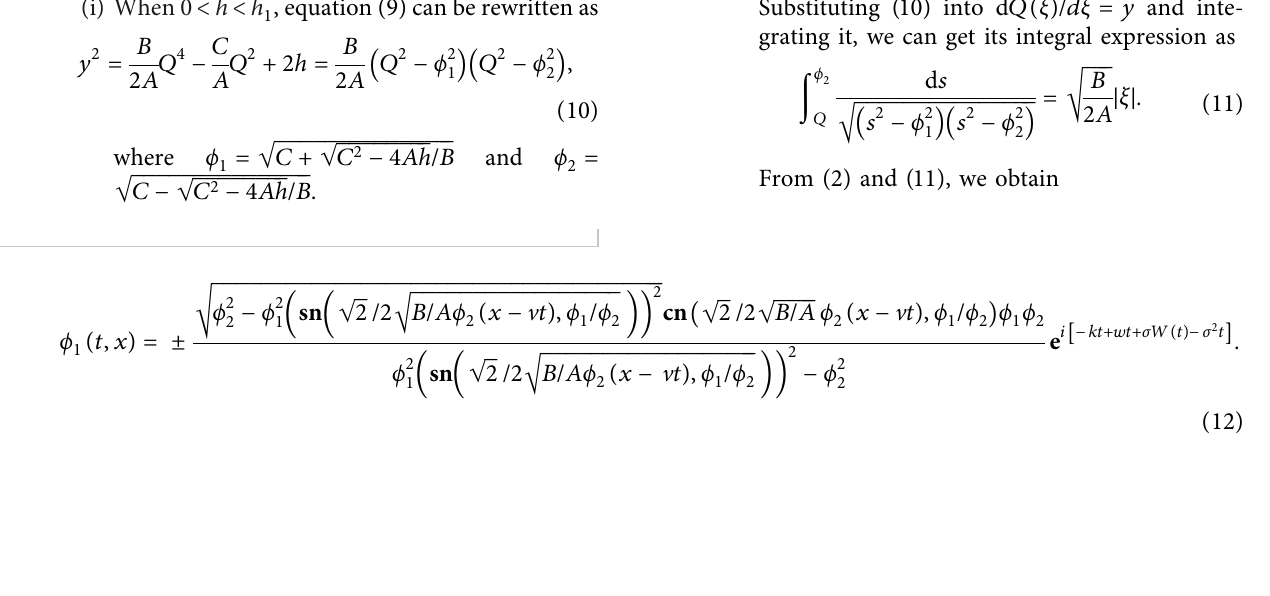
2, B 1, C 2. (b) A (cid:29) (cid:29) (cid:29)